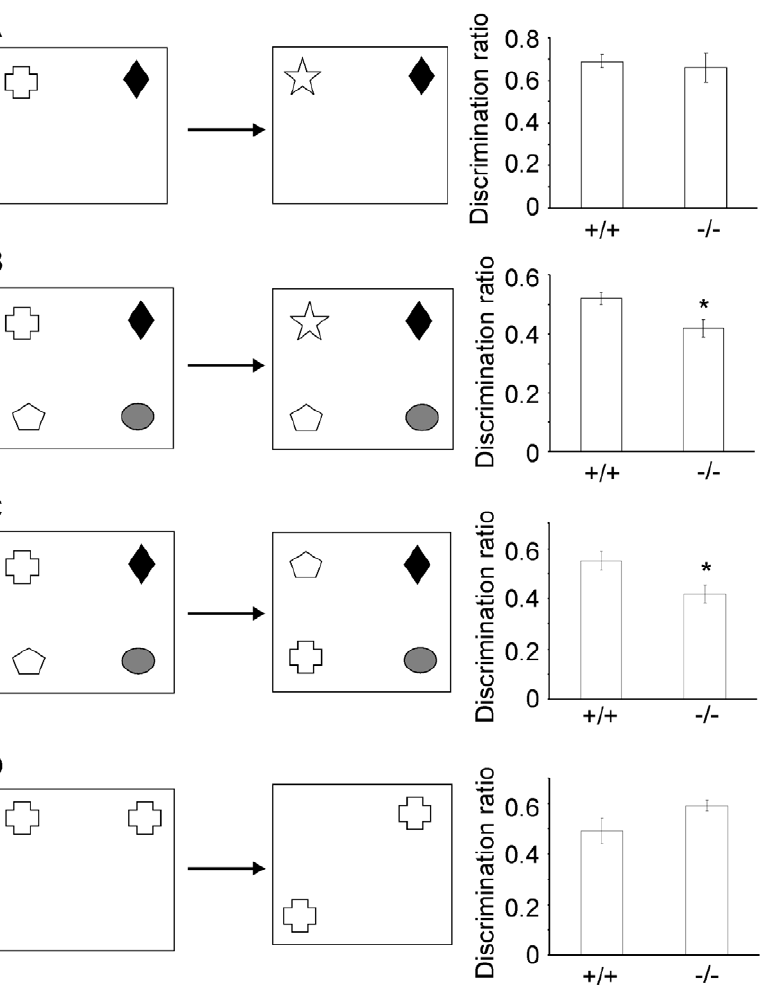
Figure 6. b -III spectrin knockout mice display deficits in some object recognition tasks. Diagram of task and performance of WT ( + / + ) and b -III spectrin knockout mice ( 2 / 2 ) in the four object recognition tasks. Two-novel object recognition (A), four-novel object recognition (B), object-in- place (C) and object location task (D). All data are mean 6 SEM (N=6–9; * P , 0.05).